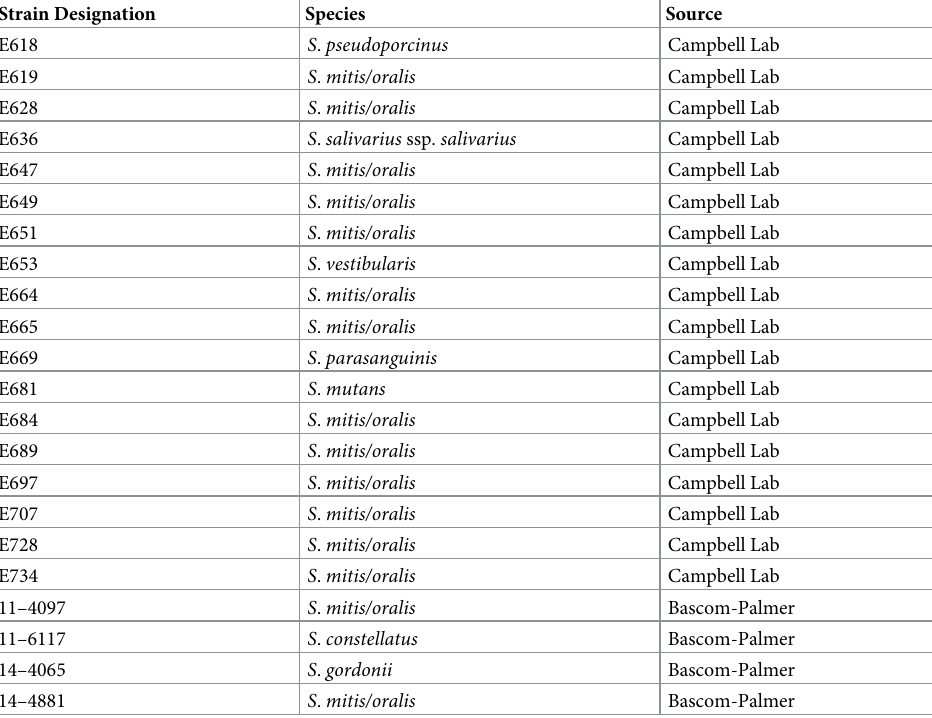
Table 1. Species identification of clinical endophthalmitis